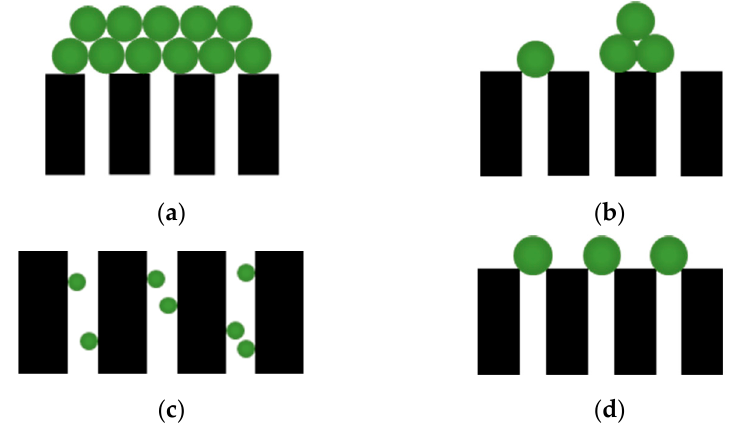
Figure 2. Schematic representation of blocking mechanisms: ( a ) cake formation; ( b ) intermediate blocking; ( c ) standard blocking; ( d ) complete blocking.